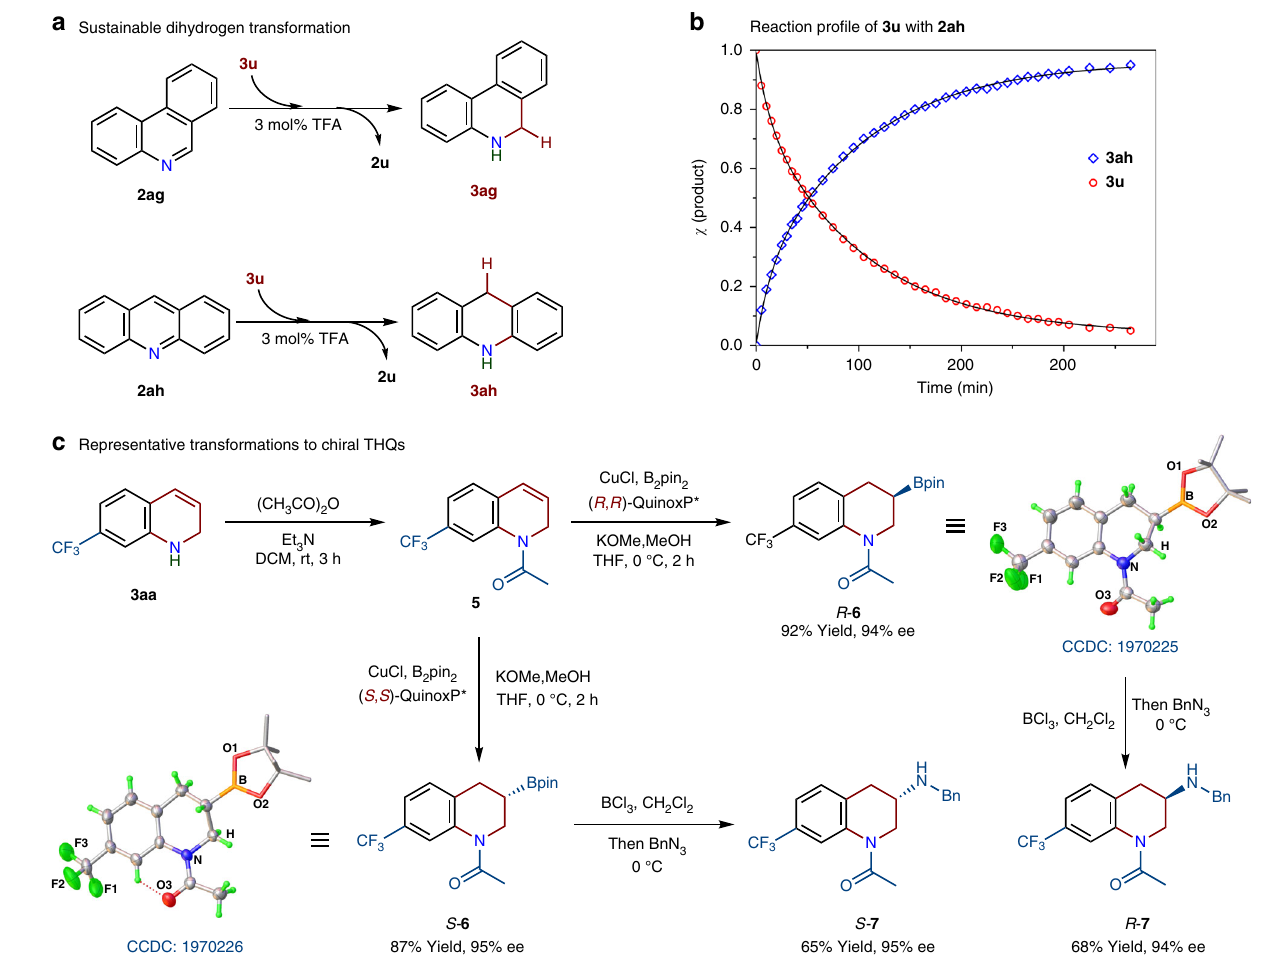
Fig. 4 Synthetic Applications. a 3u serving as reducing agent for dihydrogen transfer. b Reaction pro fi le of transfer hydrogenation of acridine ( 2ah , 0.32 M) to 9,10-dihydroacridine ( 3ah ) by 3u (0.32 M) catalyzed by CF 3 COOH (3 mol%) in THF- d 8 at 25 o C. c Asymmetric functionalization of 3aa through enantioselective borylation and amination.